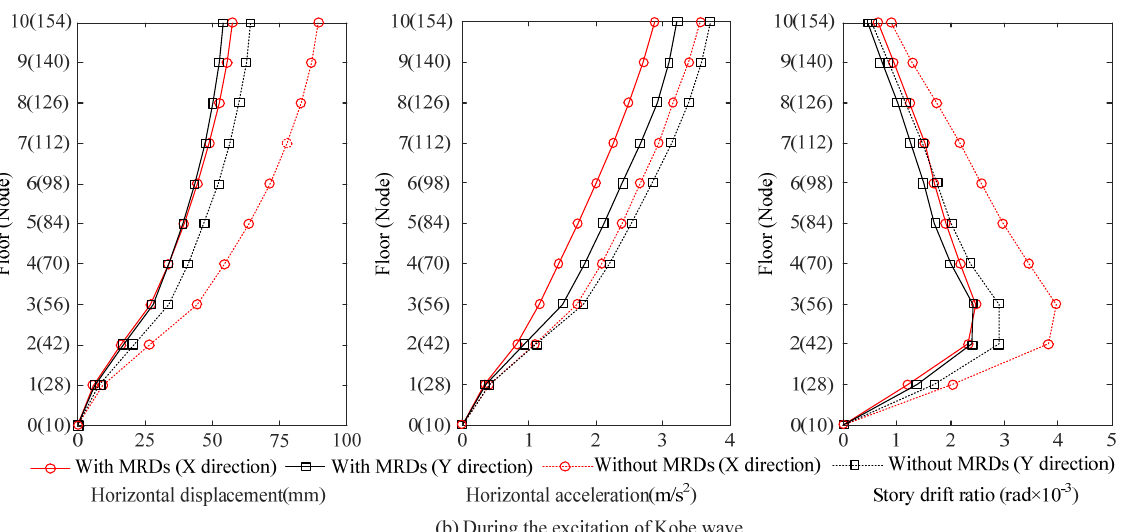
Figure 11. The max horizontal displacement, acceleration, and story drift ratio of every floor of the structure with and without MRDs.